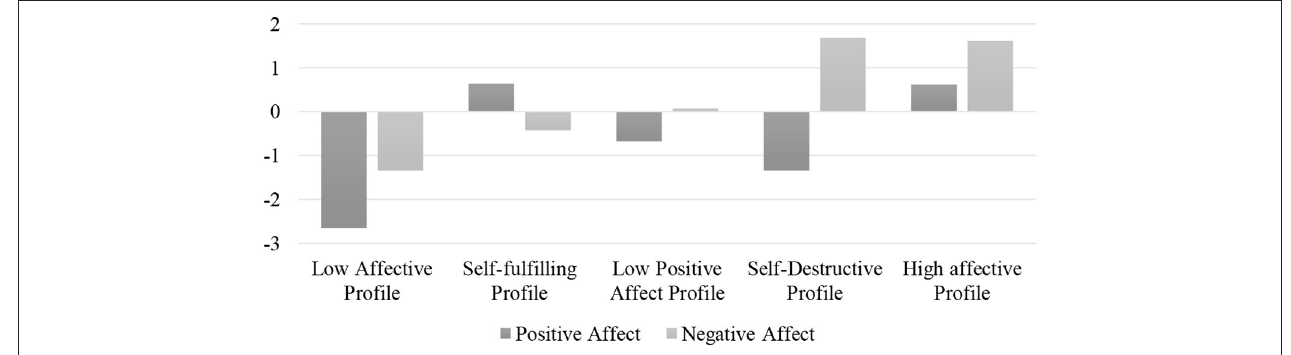
FIGURE 1 | Affective